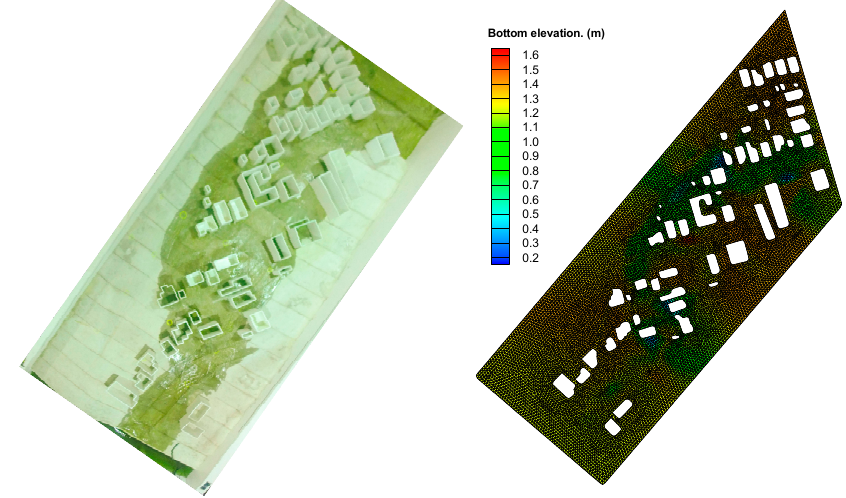
Figure 3. Model construction and configuration for analyzing urban inundation ( left : experimental flume; right : FE mesh layout).